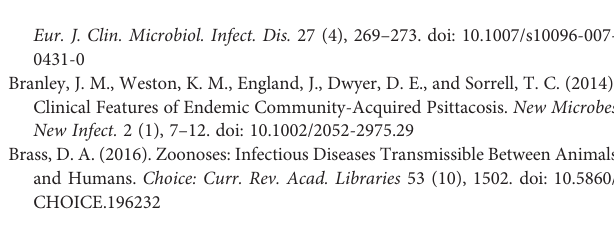
Supplementary Figure 1 | The neighbor-joining phylogenetic tree of C. Psittaci in this